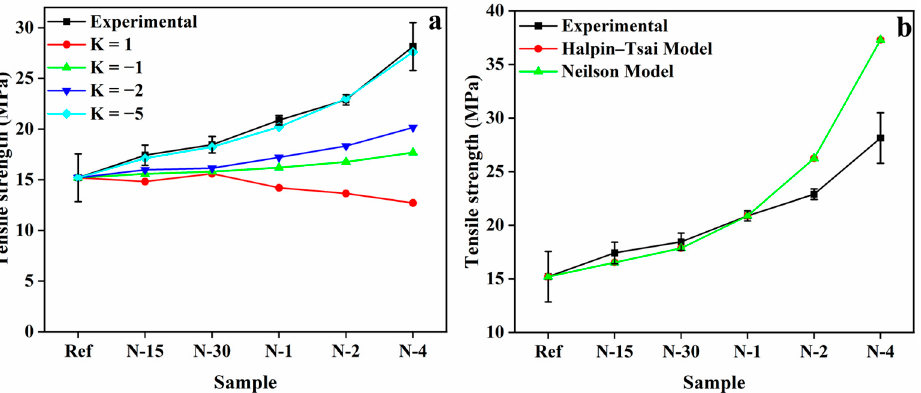
Figure 2. Correlations among the theoretical modeling values and experimental data of tensile strengths of nylon 6 nanofiber-reinforced PUA composites by ( a ) Nicolais–Narkis model, and ( b ) Halpin − Tsai model and Neilson model equations.